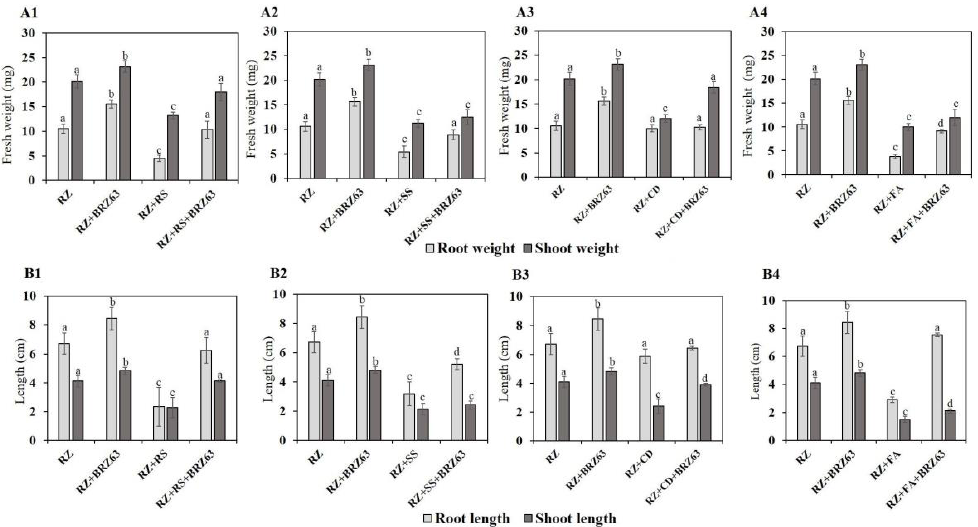
Figure 4. Effects of the BRZ63 strain on plant development and disease protection of oilseed rape. The root and shoot weights of germinating seeds after different treatments ( A1 – A4 ). The root and shoot lengths of germinating seeds after different treatments ( B1 – B4 ). The different letters (a–d) represent significant difference ( p < 0.05) in root/shoot lengths and root/shoot weights of germinating seeds. The treatments are described in Section 4.8.